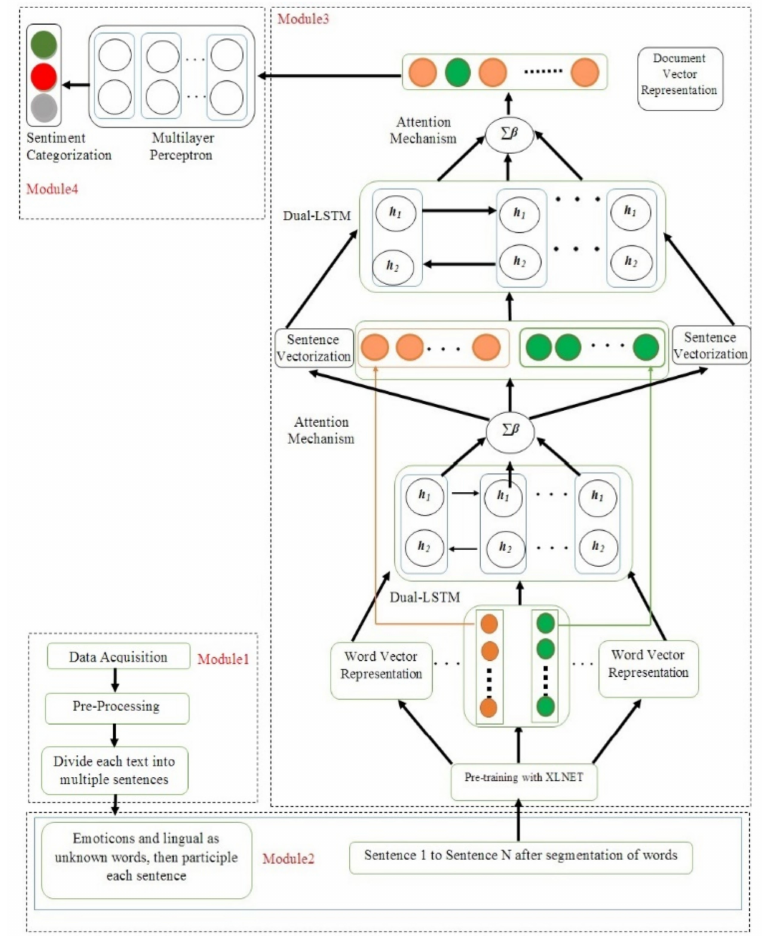
Figure 1. The proposed